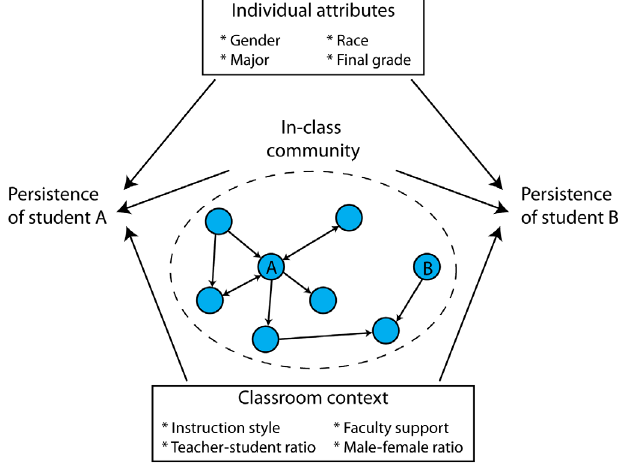
FIG. 2. Simplified Model Linking Classrooms, Learning and Persistence. The three categories of factors that may affect students ’ persistence are individual attributes, classroom context, and in-class